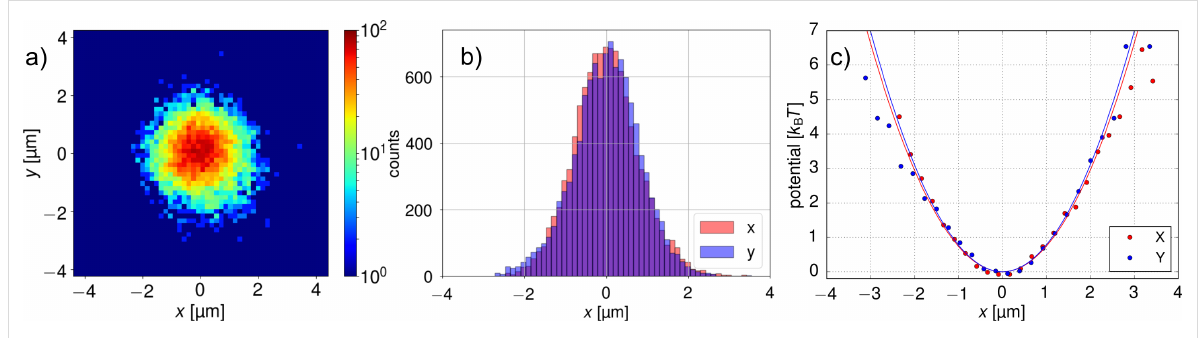
Figure 2: Thermo-optical trapping of a 200 nm polystyrene particle in water ( P las = 44 mW). (a) 2D histogram of particle positions. (b) Histogram of x - and y -positions. (c) Corresponding trap potentials in x - and y -directions obtained from (b), fitted with parabolic functions.